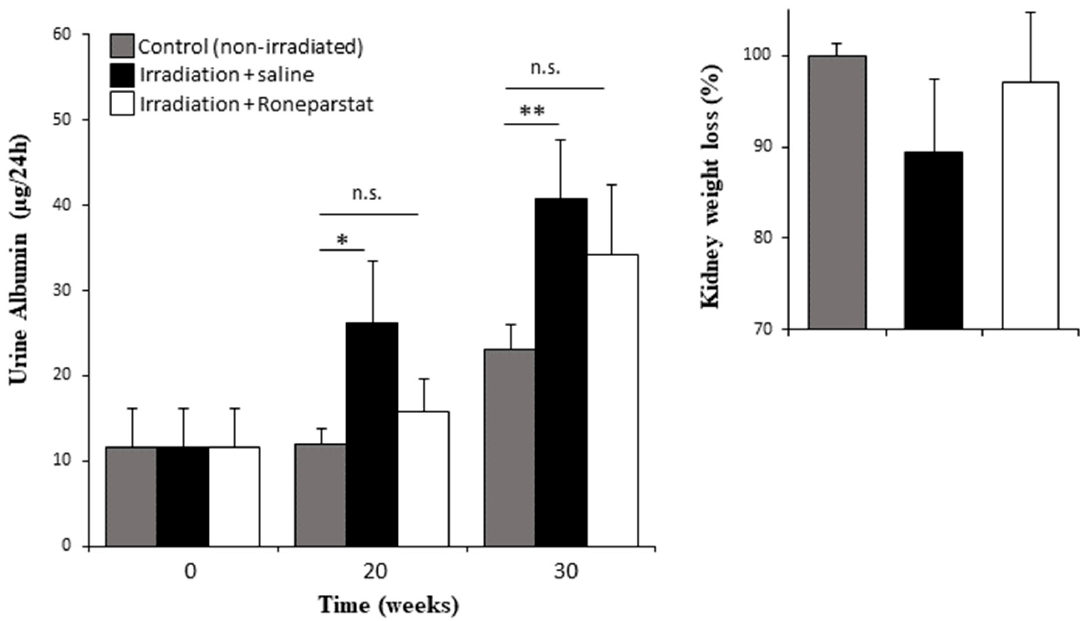
Figure 3. Effect of the heparanase inhibitor Roneparstat on urinary albumin excretion in the radiation nephropathy murine model. C3H/HeNHsd mice remained untreated (grey bars) or were treated with conformal bilateral kidney irradiation (as described in Methods) in combination with either the vehicle control (saline) alone (black bars) or with Roneparstat (white bars), administered daily for 30 weeks. Prior to irradiation (week 0) and at 20 and 30 weeks post-irradiation, 24 h urine samples were collected, and urinary albumin content was measured. Error bars represent ± SE; n ≥ 5 mice per group; * p = 0.03, ** p = 0.018, n.s.—not statistically significant. Inset. Roneparstat diminishes IR-induced renal weight reduction. Kidneys from untreated mice (grey bars) or those irradiated and treated with either the vehicle control (saline) alone (black bars) or Roneparstat (white bars) were harvested and weighed 30 weeks post-irradiation. Data represent the mean left kidney weight ± SE.